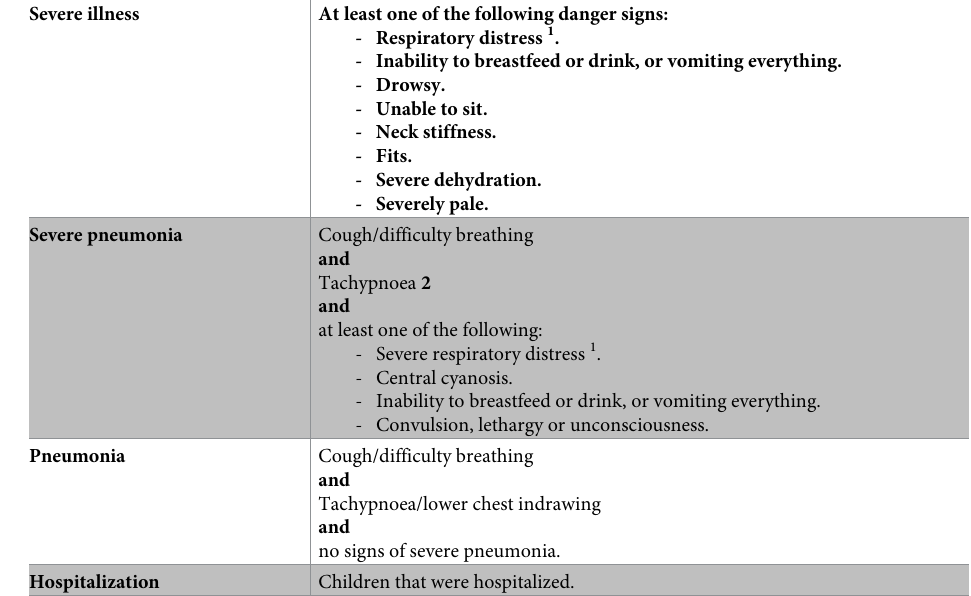
Table 1. Outcome definitions. Severe